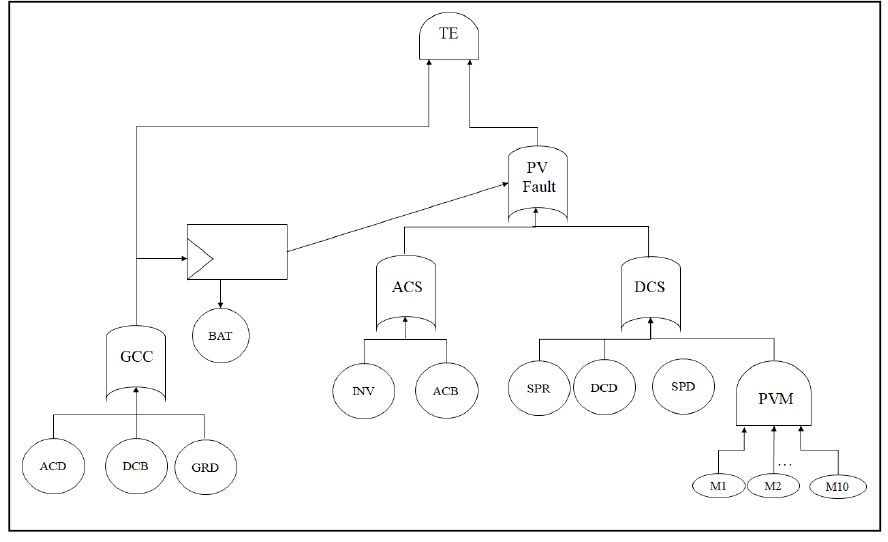
Figure 6. Dynamic Fault Tree (DFT) of the energy supply of a domestic household equipped with a PV system.